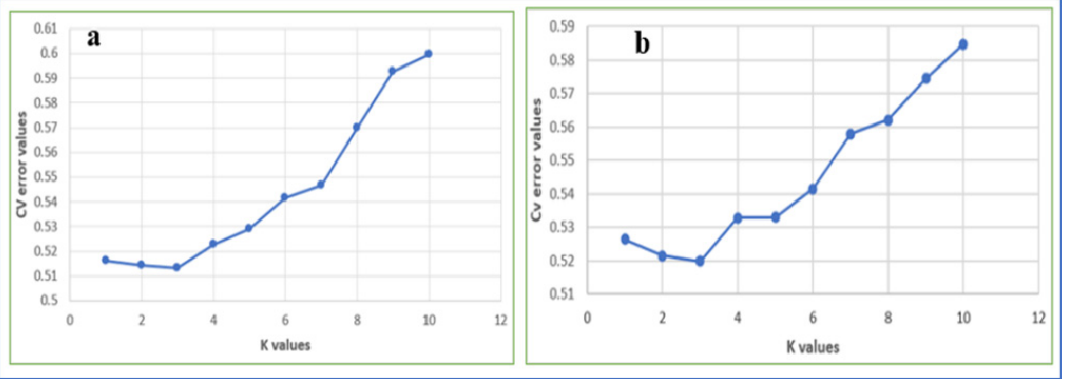
Figure 7. The plot of cross-validation error developed for ( a ) continental and ( b ) local Sudanese sheep populations.